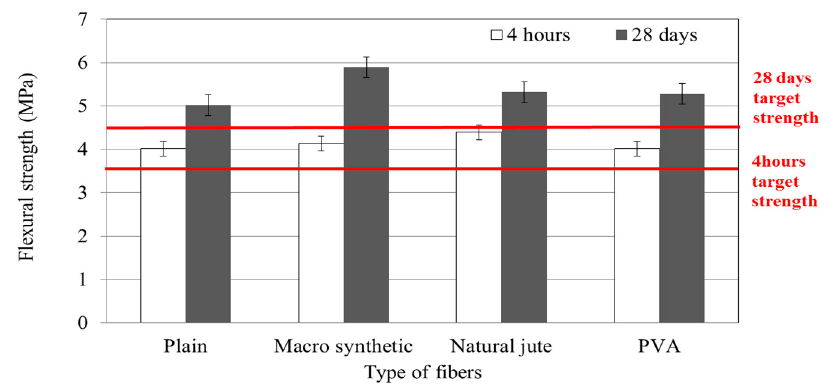
Figure 8. Flexural strength of RCLMFRRHCC.